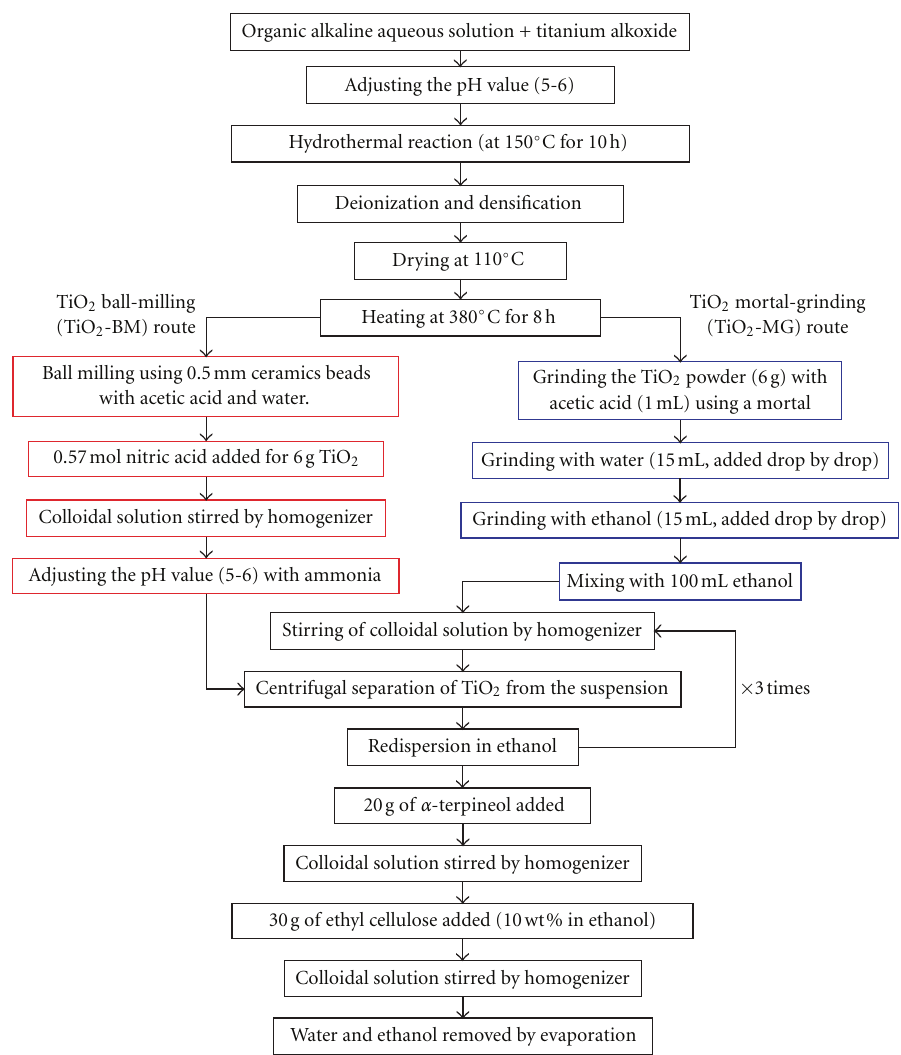
Figure 1: Fabrication methods of TiO 2